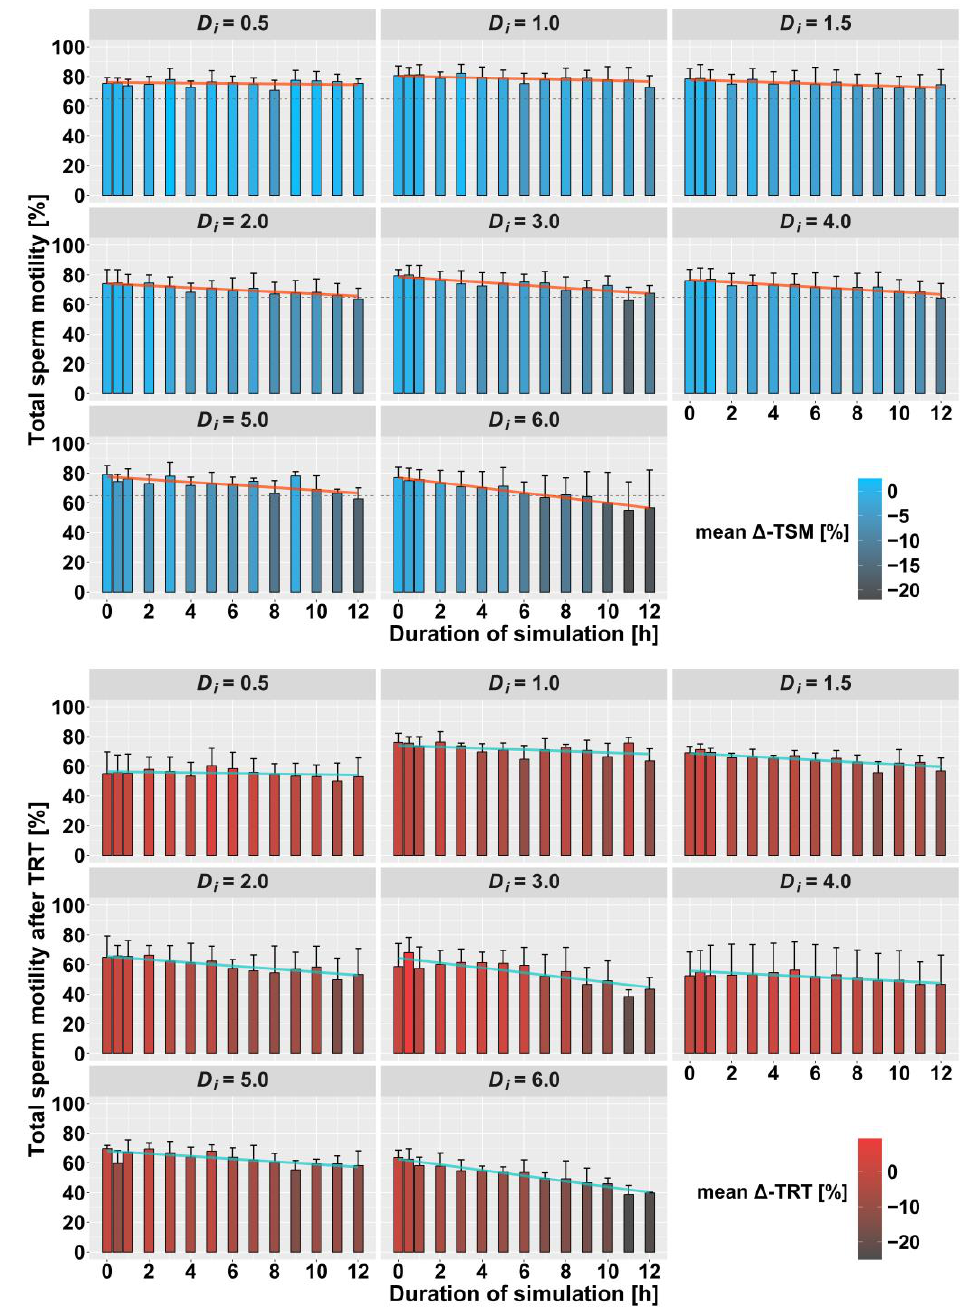
Figure 1. Summary of CASA measurements on day 4 after treatment: ( a ) total sperm motility after 10 min incubation at 38 °C (TSM, n = 546 samples); ( b ) total sperm motility after 300 min incubation at 38 °C (thermo-resistance test TRT, n = 336 samples). Mean absolute values, grouped by intensity (D i ) and duration (h) of vibration treatment, are shown as bars with standard deviation (SD) as the error bar. The color of the bars represents the mean difference (Δ) to the control group (duration = 0 h). The colored line shows the values of the applied regression model, and the dashed line in ( a ) stands for the minimum requirement of 65% motile spermatozoa on the expiration day.